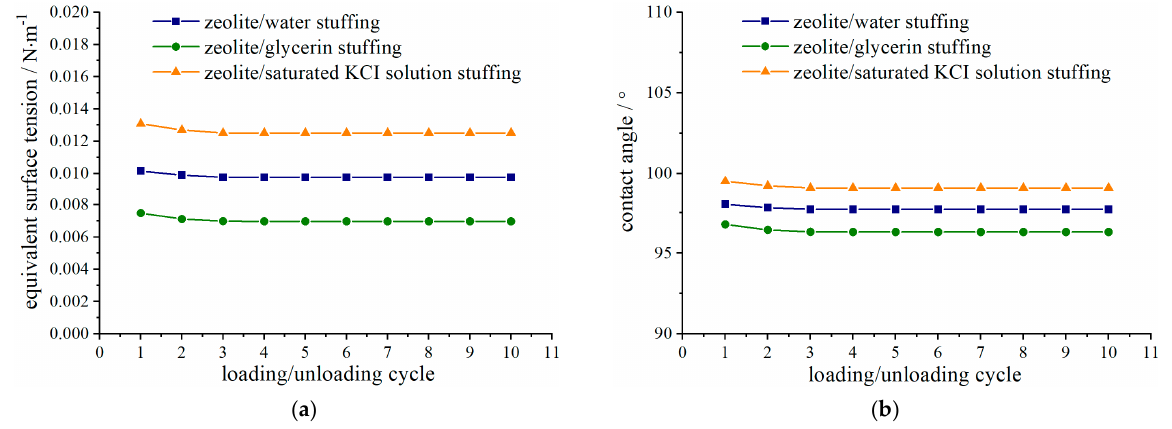
Figure 5. Equivalent surface tension and contact angle of three kinds of zeolite-based stuffing under ten cyclic loadings (ZSM-5 zeolite/water stuffing, ZSM-5 zeolite/glycerin stuffing, and ZSM-5 zeolite/saturated KCl solution stuffing): ( a ) equivalent surface tension; ( b ) contact